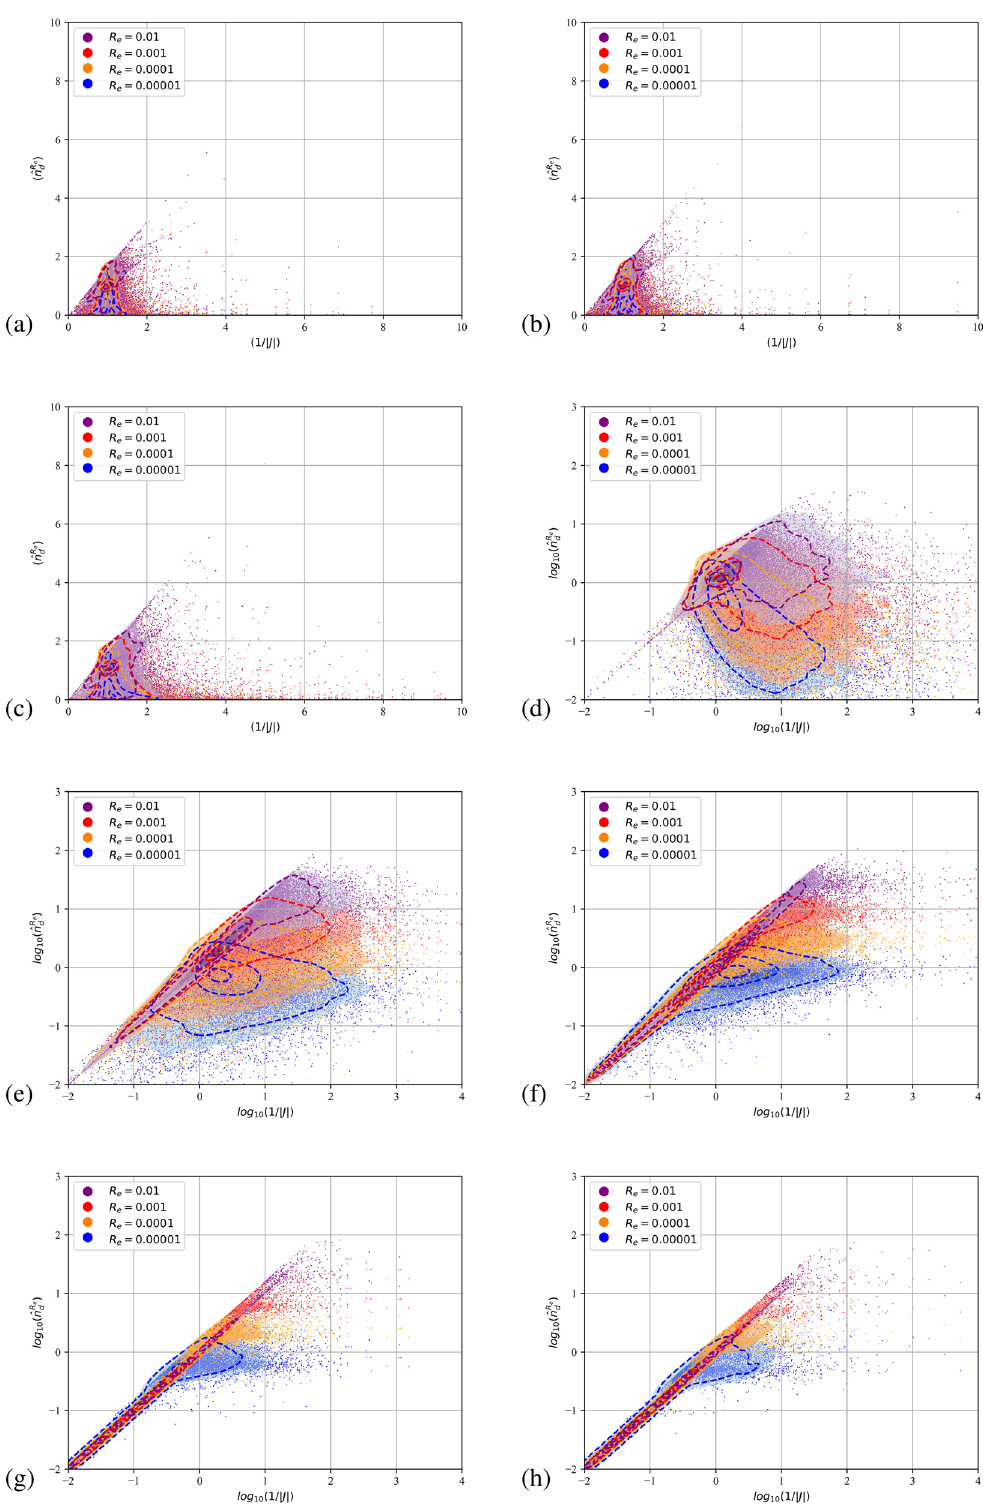
Figure 5. Scatter plot of the filtered FLA2 number density versus 1/ J . Colours correspond to the filtering length. Dashed iso-lines correspond to the kernel density estimation at levels 10% 50% and 90%. Case C3DN2. T = 4 ms.( a – h ) D d = 0.5 – 100 µ m. ( d – h ) are presented in logarithmic